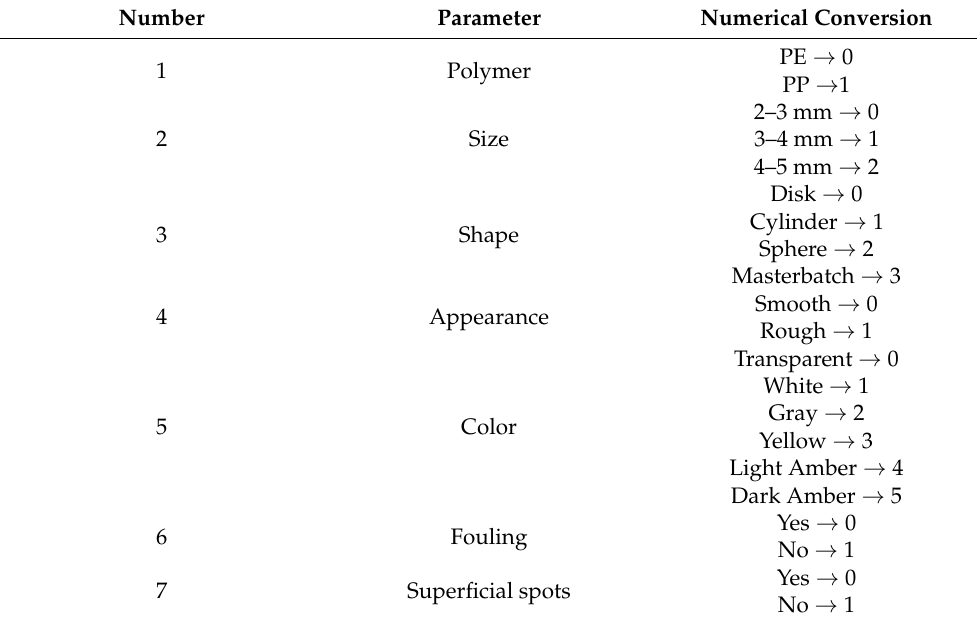
Table 2. Parameters and numerical conversion for physical classification of the pellets.